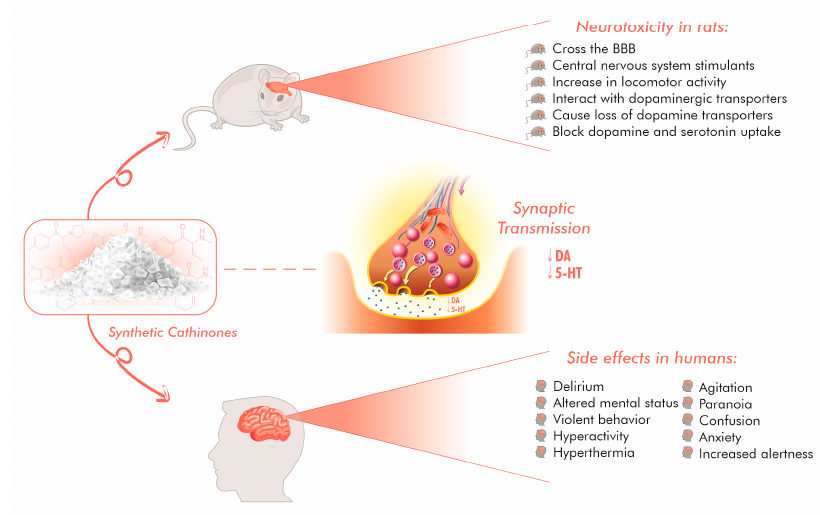
Figure 3. SCs’ mechanism of action and effects on rat and human brain. Synthetic cathinones act as blockers or substrates of DAT, SERT and NET. In this way they increase DA (dopamine), 5-HT (serotonon) or NA (norepinephrine) neurotransmission.